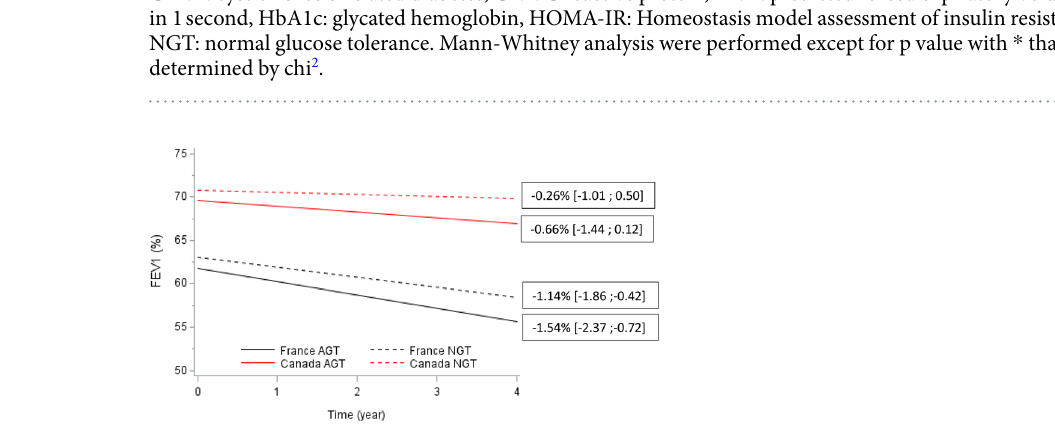
Figure 1. Insulin secretion ( μ U/dl) at start, 1-h and 2-h of the OGTT for. ( a ) NGT, ( b ) AGT and ( c ) CFRD patients according to their respective cohorts: black dot ( • ) for Canadian patients and black square ( ◼ ) for French patients. Values are presented as mean ± SEM. Abbreviations: AGT: abnormal glucose tolerance, CA: Canadian patients, CFRD: cystic fibrosis-related diabetes, FR: French patients, NGT: normal glucose